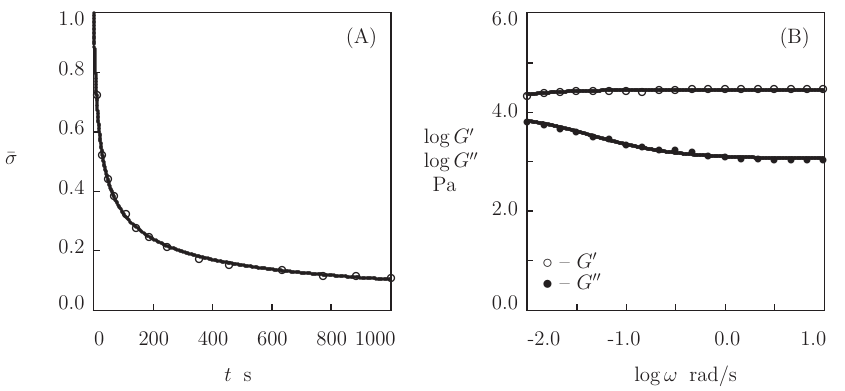
Figure 6. ( A )–Normalized stress ¯ σ = σ ( t ) / σ ( 0 ) versus relaxation time t . ( B )–Storage modulus G (cid:48) and loss modulus G (cid:48)(cid:48) versus frequency ω . Circles: experimental data [70] on PEG-DDI gel with hydrophobic interactions. Solid lines: the results of